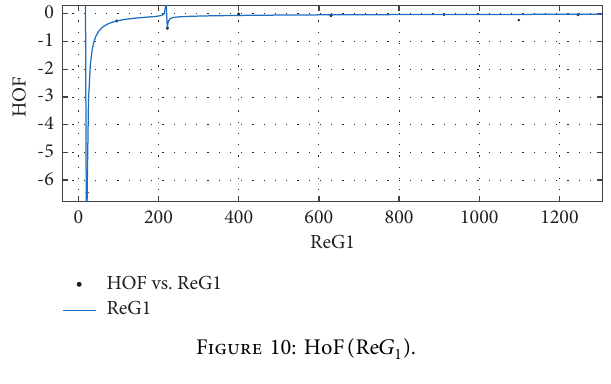
Figure 10: HoF ( Re G